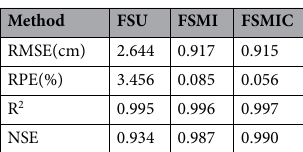
Table 6. Comparison of recorded and computed water depths of FS